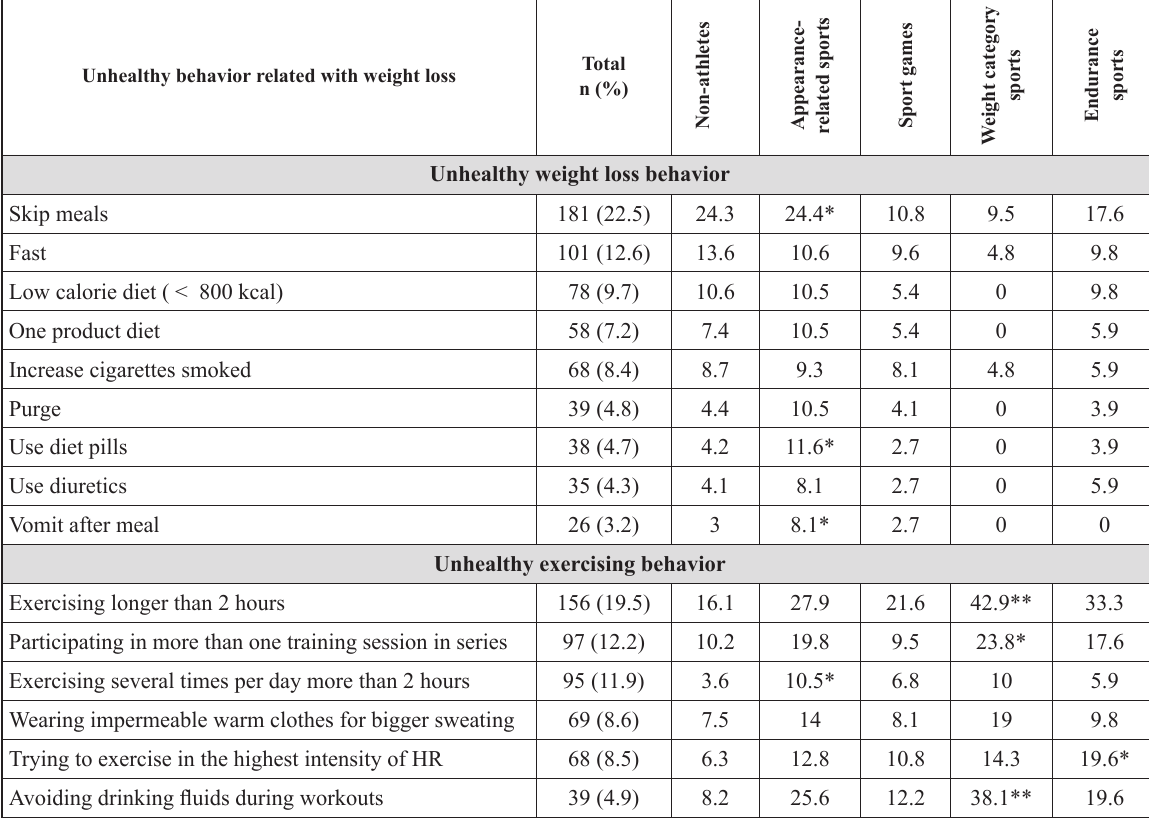
Table 3. Expression of weight control behavior in sport groups (%)